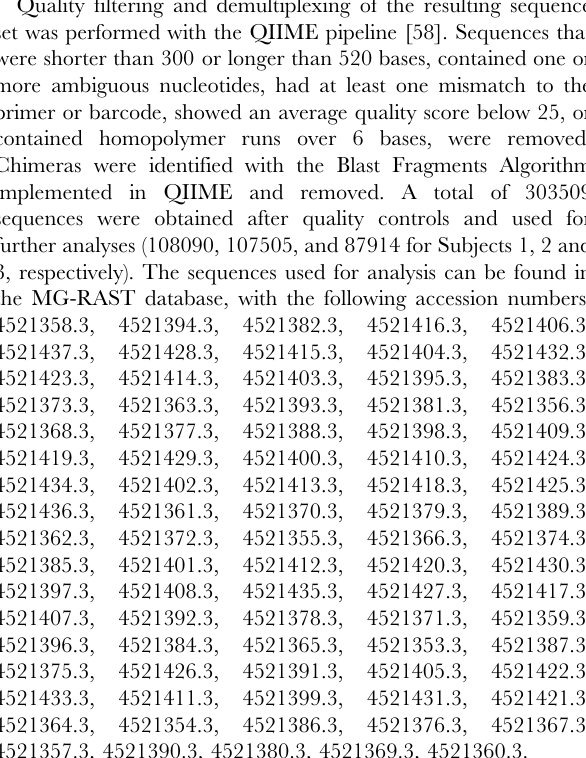
Figure S1 Principal-coordinates plots of the beta-diver- sity measurements based on unweighted UniFrac dis- tances among samples. Samples were color-coded by subject